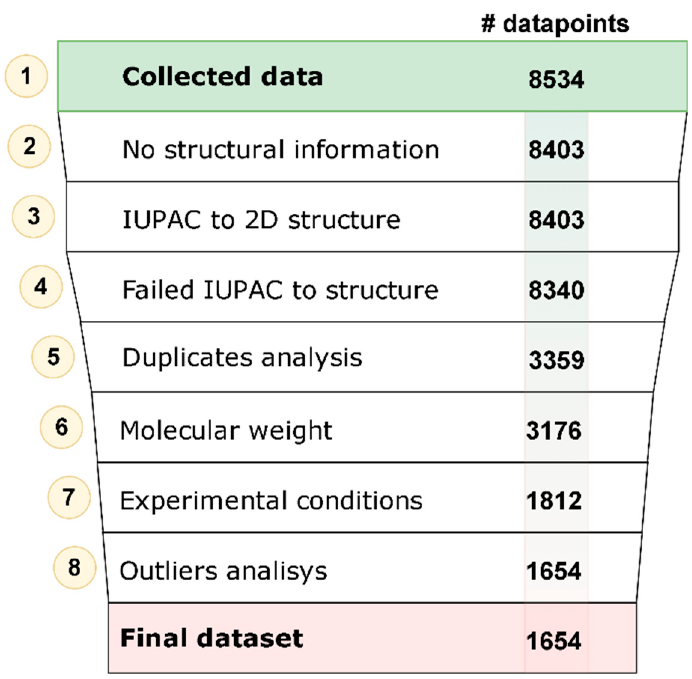
Figure 2. Data curation workflow. Number of data points shown in each row represent the number of compounds left after the respective curation step. Table 1. Distribution of cyclodextrin (CD) derivatives in the final dataset.